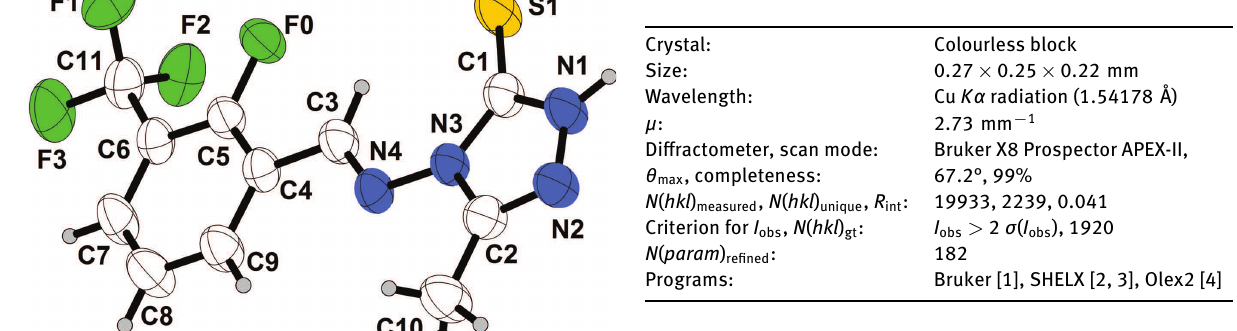
Table 1: Data collection and handling.